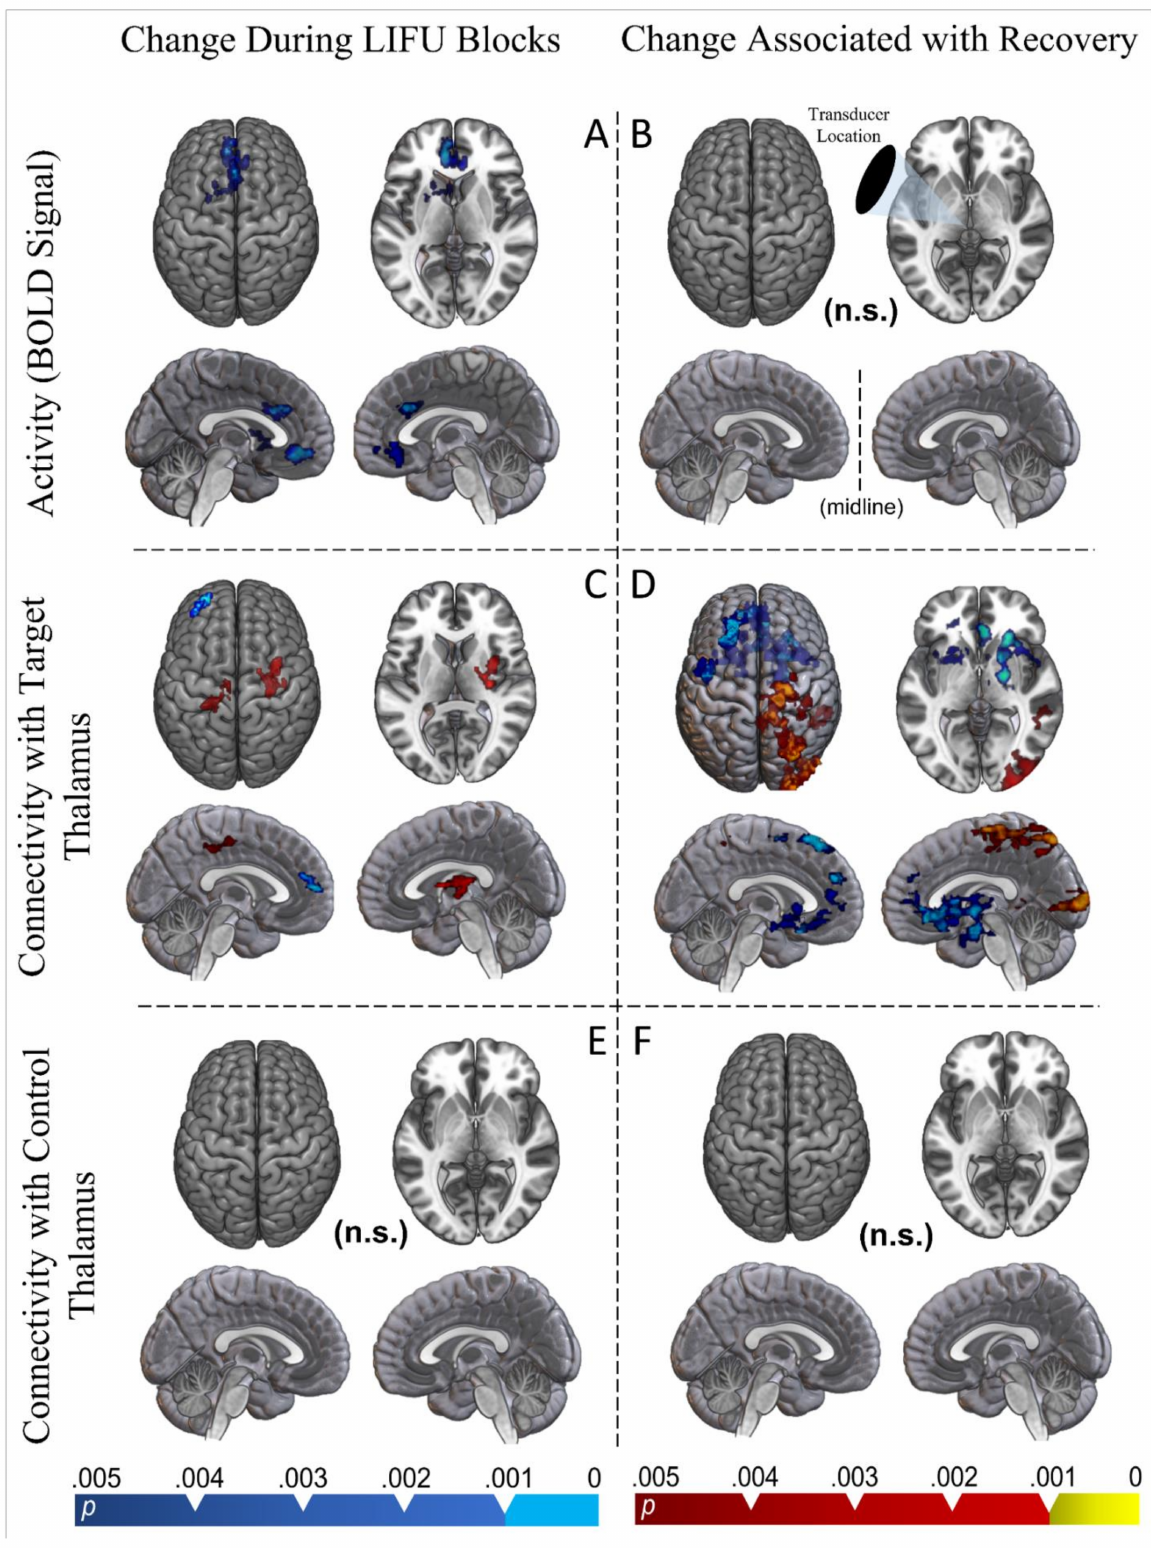
Figure 3. Whole brain results. For all analyses, statistical maps were obtained using a fixed-effects model as implemented in FSL6.0.1, and are shown at two levels of cluster correction for multiplicity (CDT set at p < 0.005, in blue, and at p < 0.001 in violet). Note that sagittal images are shown from the midline and each shows one hemisphere. ( A ) Regions of significant change in BOLD signals